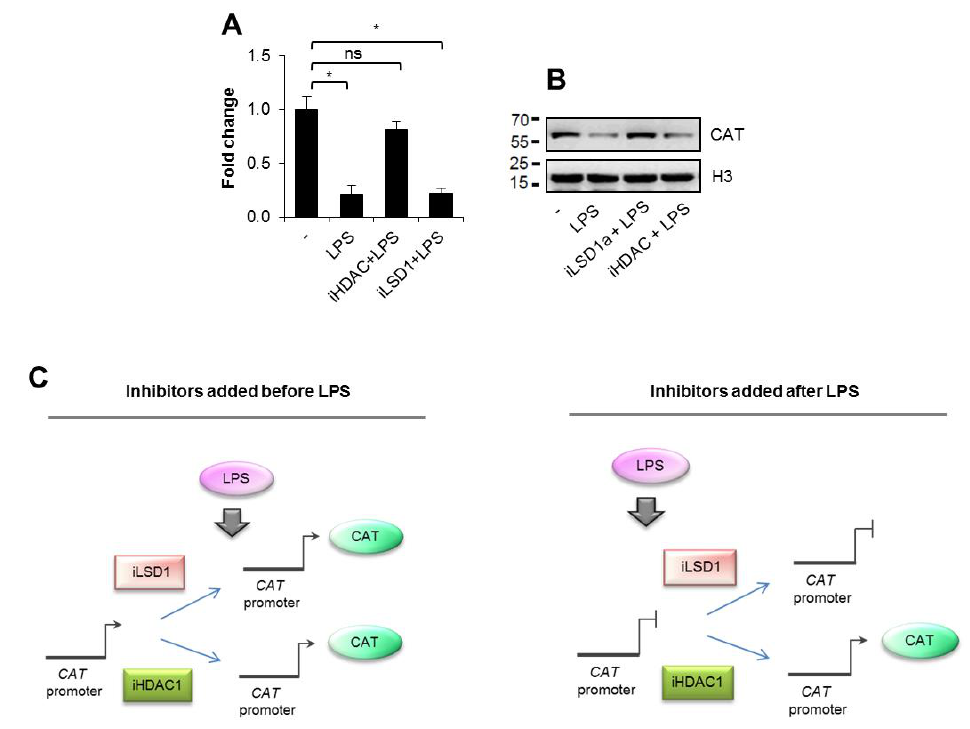
Figure 4. The inhibition of HDACs, but not LSD1, reverses CAT suppression in pro-inflammatory macrophages. iHDAC (200 µM sodium butyrate) and iLSD1a (0.1 µM SP2509) were used to restore transcription of CAT in pro-inflammatory macrophages. The two inhibitors were added 24 h after cell stimulation with LPS (10 ng/mL) for another 24 h. The mRNA level ( A ) was quantified by real-time PCR, whereas protein level ( B ) by Western blot. ( C ) The scheme shows the difference in the iLSD1 effect on the CAT expression depending on the macrophage phenotype. The treatment of non-polarized phagocytes with both inhibitors prevents CAT repression induced by LPS (left panel), but only iHDAC1 restores CAT transcription in M1 macrophages (right panel). Western blots show representative images from three independent experiments. Bars in the figures represent mean ± standard error of the mean (SEM). One-way analysis of variance (ANOVA) was carried out in GraphPad Prism 5 to compare means in several groups and the differences between each two groups were tested with the Tukey post hoc test (marked with * when p < 0.05, with ns when p >